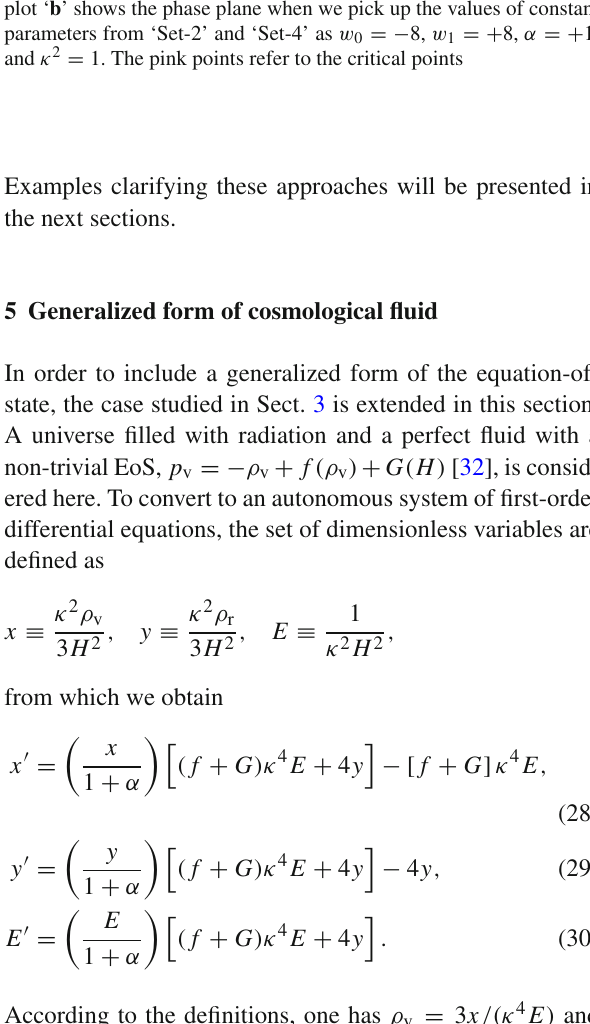
plot ‘ b ’ shows the phase plane when we pick up the values of constant parameters from ‘Set-2’ and ‘Set-4’ as w 0 = − 8, w 1 = + 8, α = + 1, and κ 2 = 1. The pink points refer to the critical